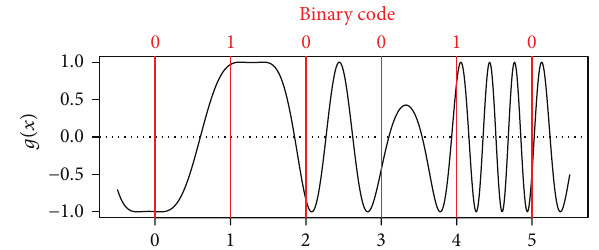
Figure 1: Generating a bit vector by sampling the function with 𝑎 = 0.6 , 𝑏 = 0.6 , 𝑐 = −0.2 , and 𝑑 = 0